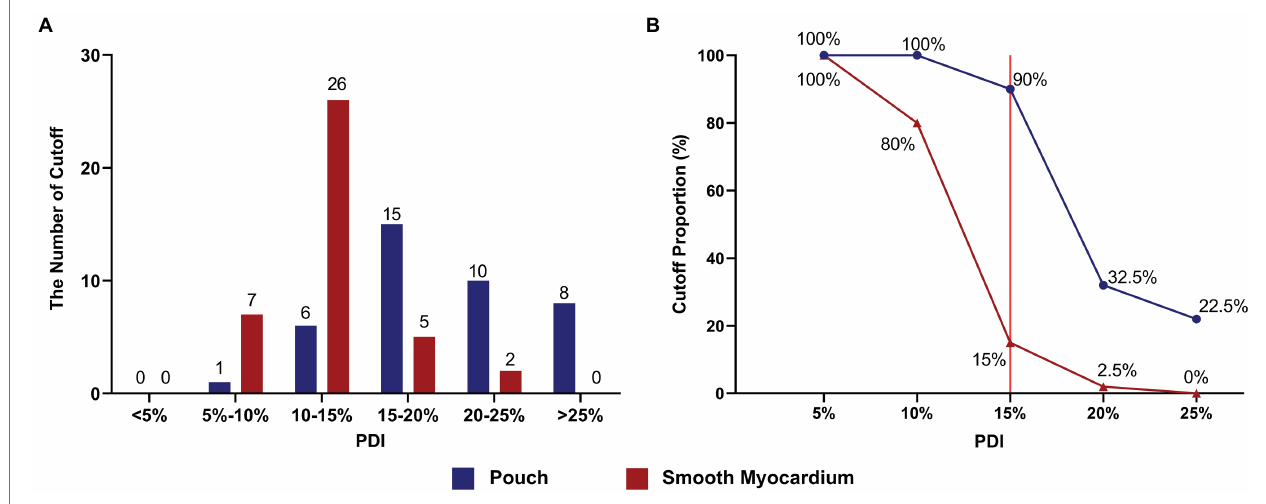
FIGURE 4 | Appropriate PDI cutoff settings effectively prevented SPs. (A) The number of ablation lesions with PDI values (< 5%, 5–10%, 10–15%, 15–20%, 20– 25%, and > 25%) during the first 3 s of RFA in the pouch group and smooth myocardium group. (B) The frequency of invoked cutoffs at different PDI settings. Red line indicates that at the optimal PDI setting of 15%, the cutoff rate in the pouch group was 90%, while RFA application was only terminated in 15% of all cases in the smooth myocardium